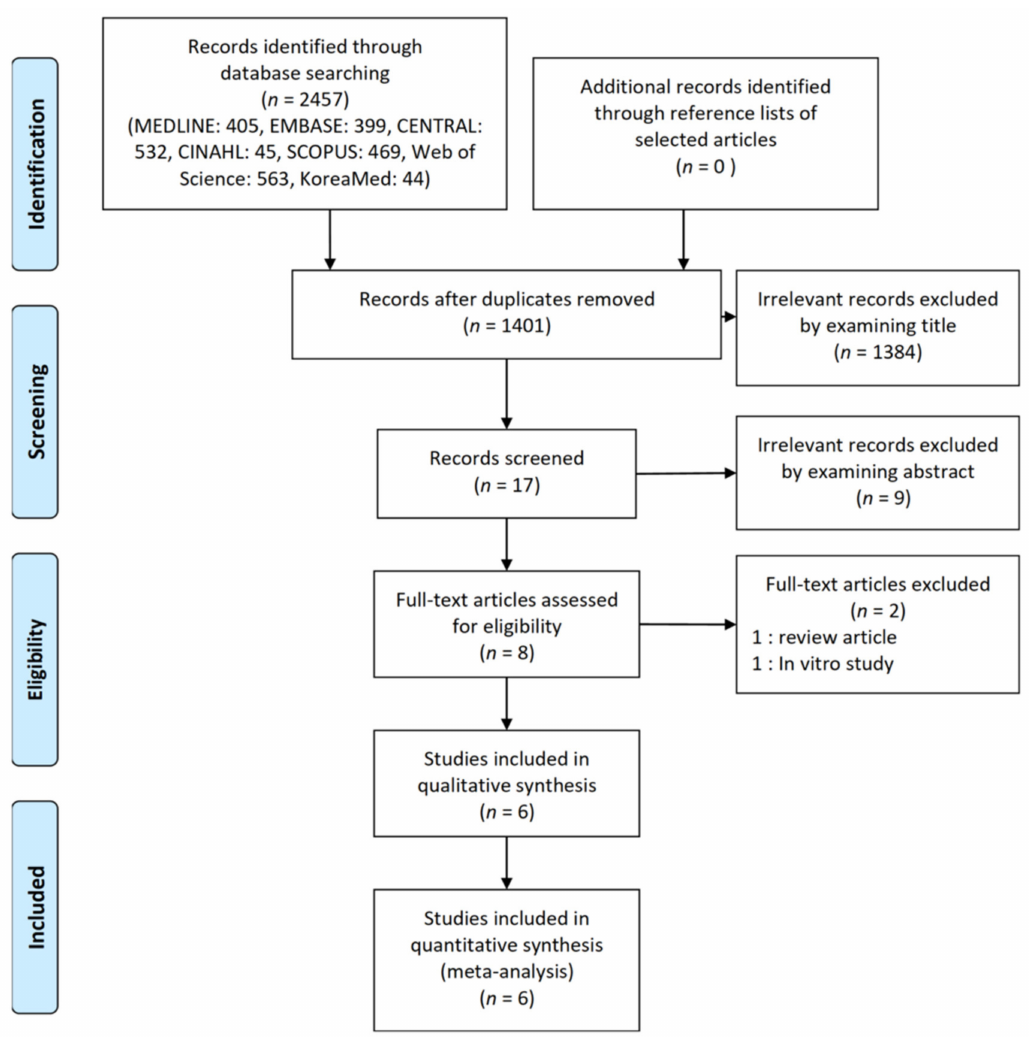
Figure 1. Flow diagram of included and excluded